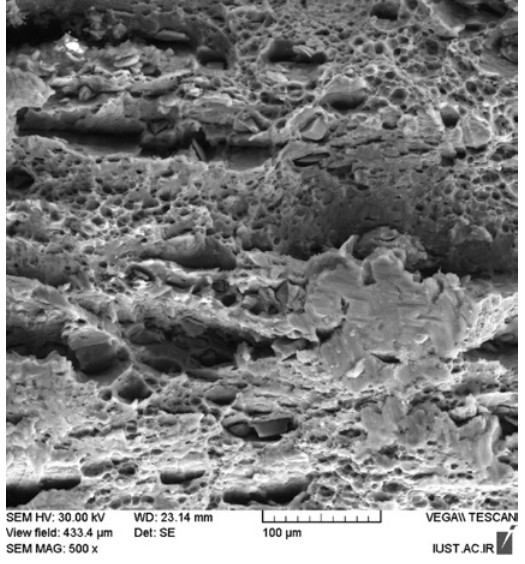
Figure 6: SEM micrograph of the fracture surface of AA8090/6% SiC composite at peak aged under conventional T p